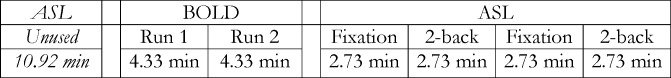
Scan day study design.Each BOLD run comprised 10 s fixation, 50 s 2-back, 30 s fixation, 50 s 2-back, 30 s fixation, 50 s 2-back, and 40 s fixation.